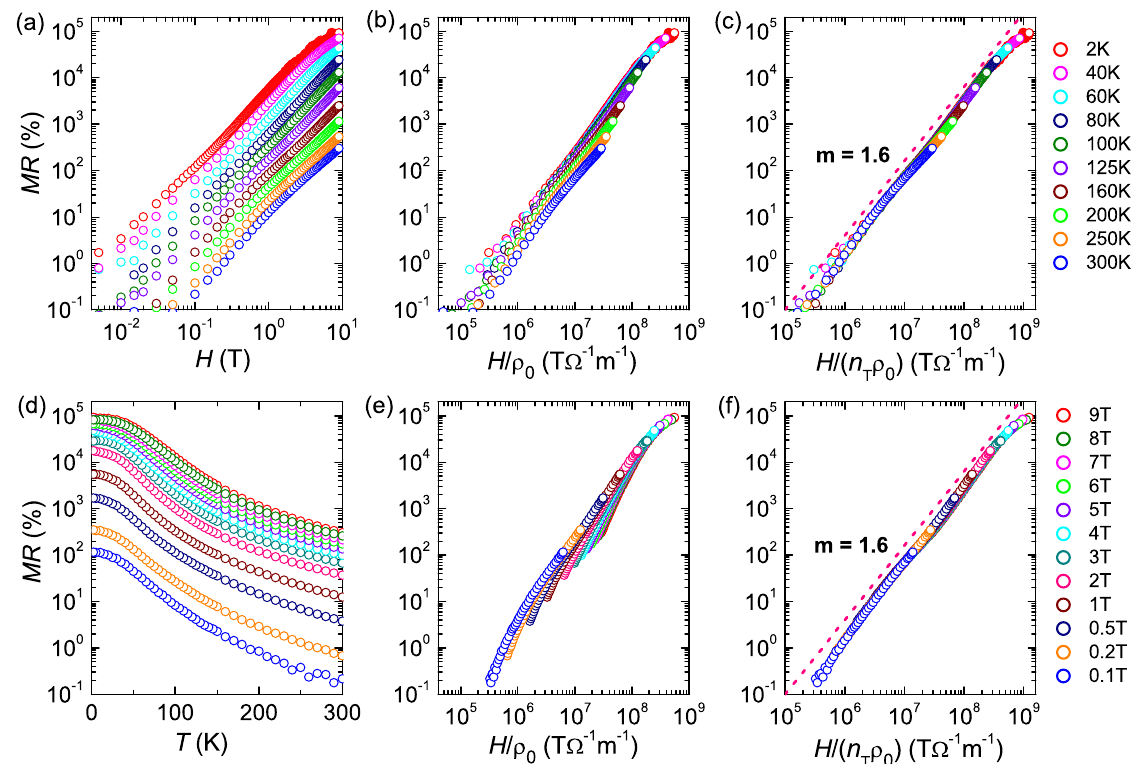
FIG. 2. Extended Kohler ’ s rule of the magnetoresistance in TaP (sample TP1). (a),(d) Magnetic field and temperature dependences of the MR derived from data in Figs. 1(a) and 1(b), respectively. For clarity, (a) presents only partial MR ð H Þ curves derived from the ρ ð H Þ data in Fig. 1(a). (b),(e) Kohler ’ s rule plots of the data in (a) and (d), respectively. (c),(f) Extended Kohler ’ s rule plots of the MR xx curves in (a) and (d), respectively. The legends for (a) – (c) are on the top right, while legends for (d) – (f) are on the bottom